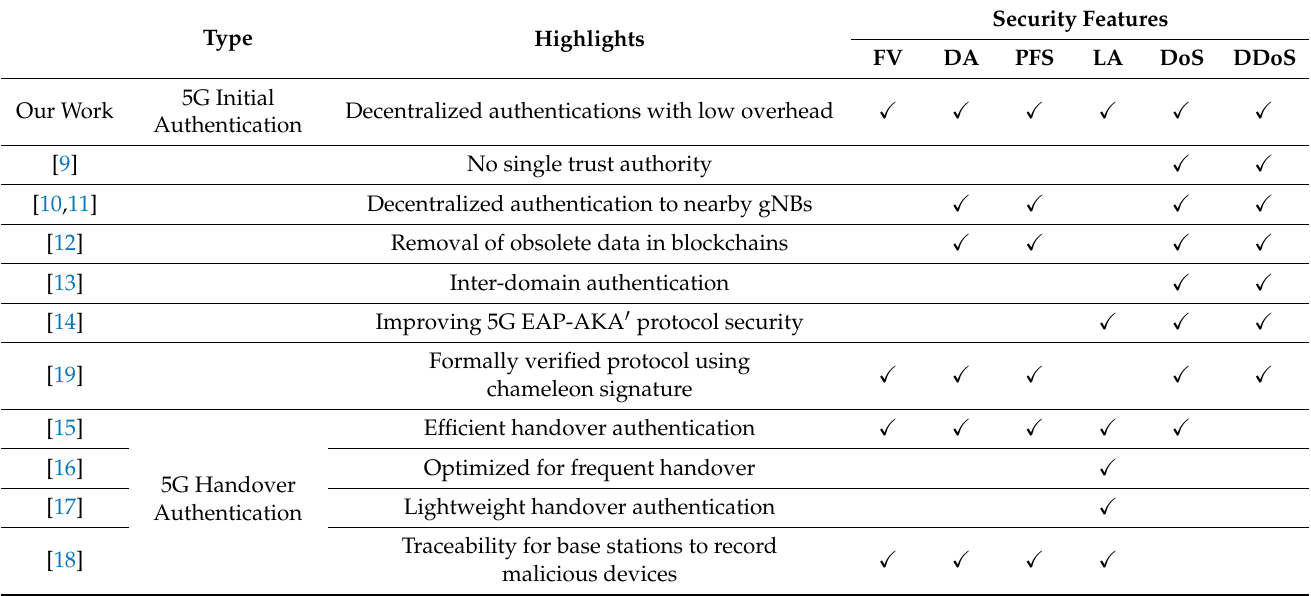
Table 1. Recent works on blockchain-based 5G authentication